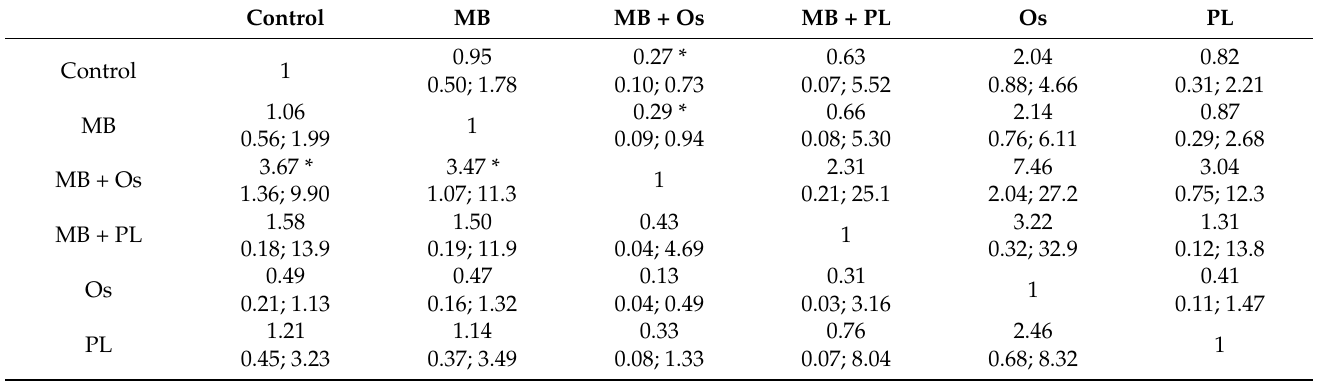
Table 3. Comparison between GTR techniques using OR and 95% confidence intervals estimated in Netmeta. * p <